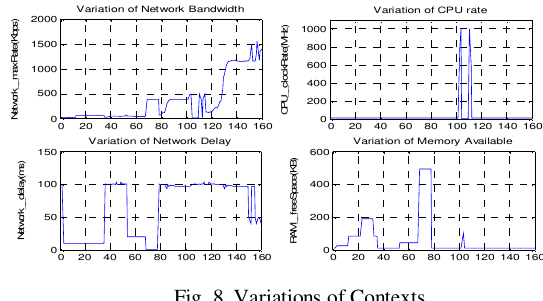
Fig. 8. Variations of Contexts